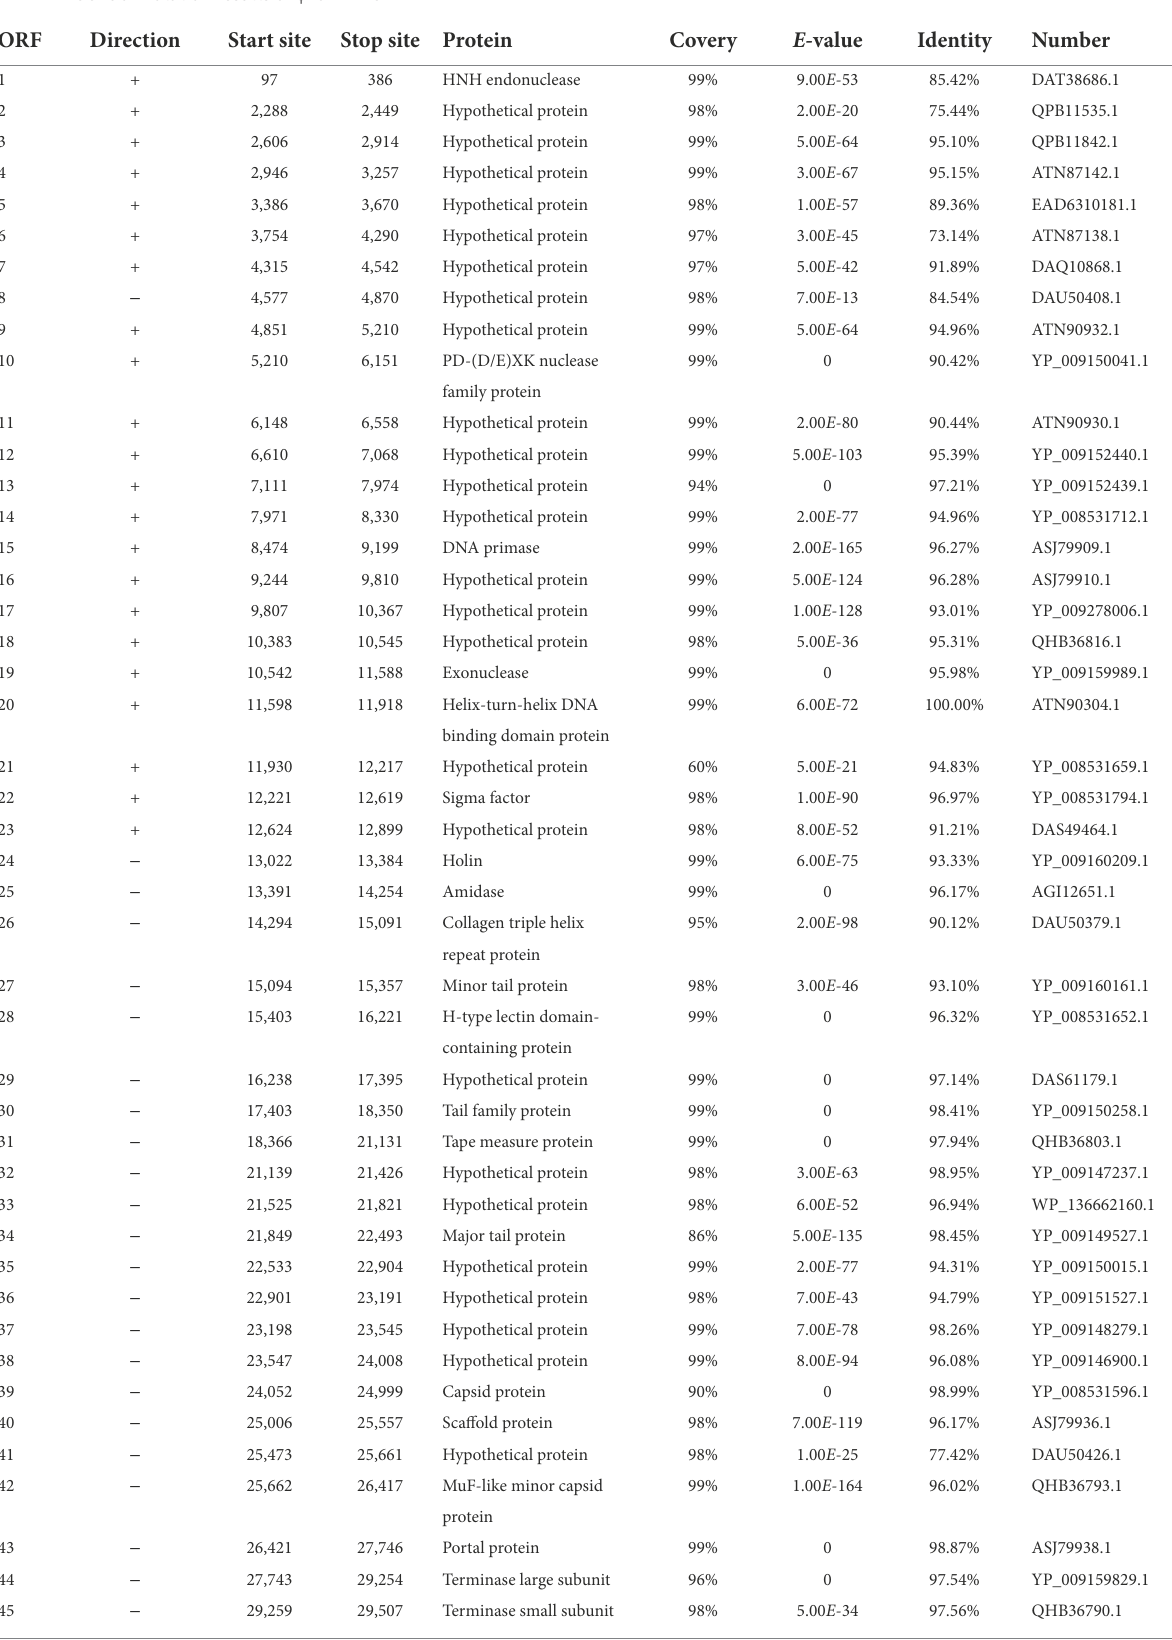
TABLE 4 Gene annotation results of φ